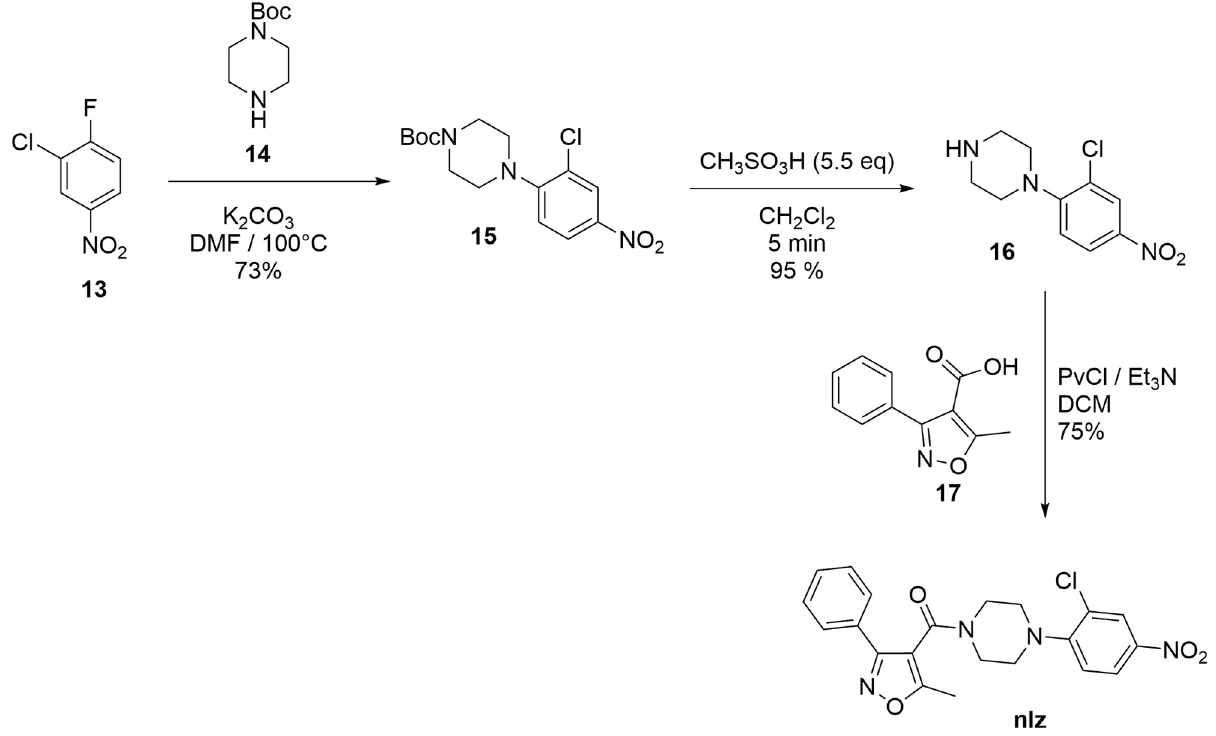
Fig 3. Synthesis of